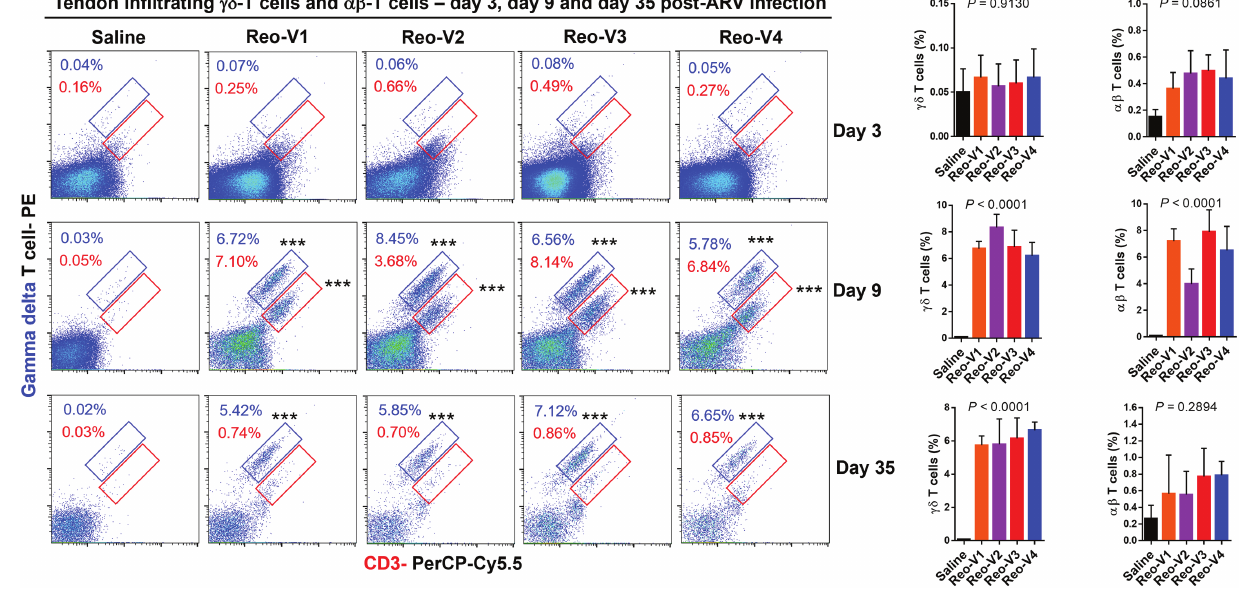
FIGURE 6 | Flow cytometry analysis of γδ + CD3 + and γδ − CD3 + T lymphocytes infiltrating tendon tissues of birds infected with different ARVs [i.e., Reo-V1 (Cluster-5), Reo-V2 (Cluster-4), Reo-V3 (Cluster-2), or Reo-V4 (Cluster-6)] at the indicated time points post-infection. The bar diagrams indicate the mean (±SD: standard deviation) total γδ + CD3 + T lymphocyte percentages based on three separate experiments. Asterisks indicate groups that were significantly different from the control group, *** p <